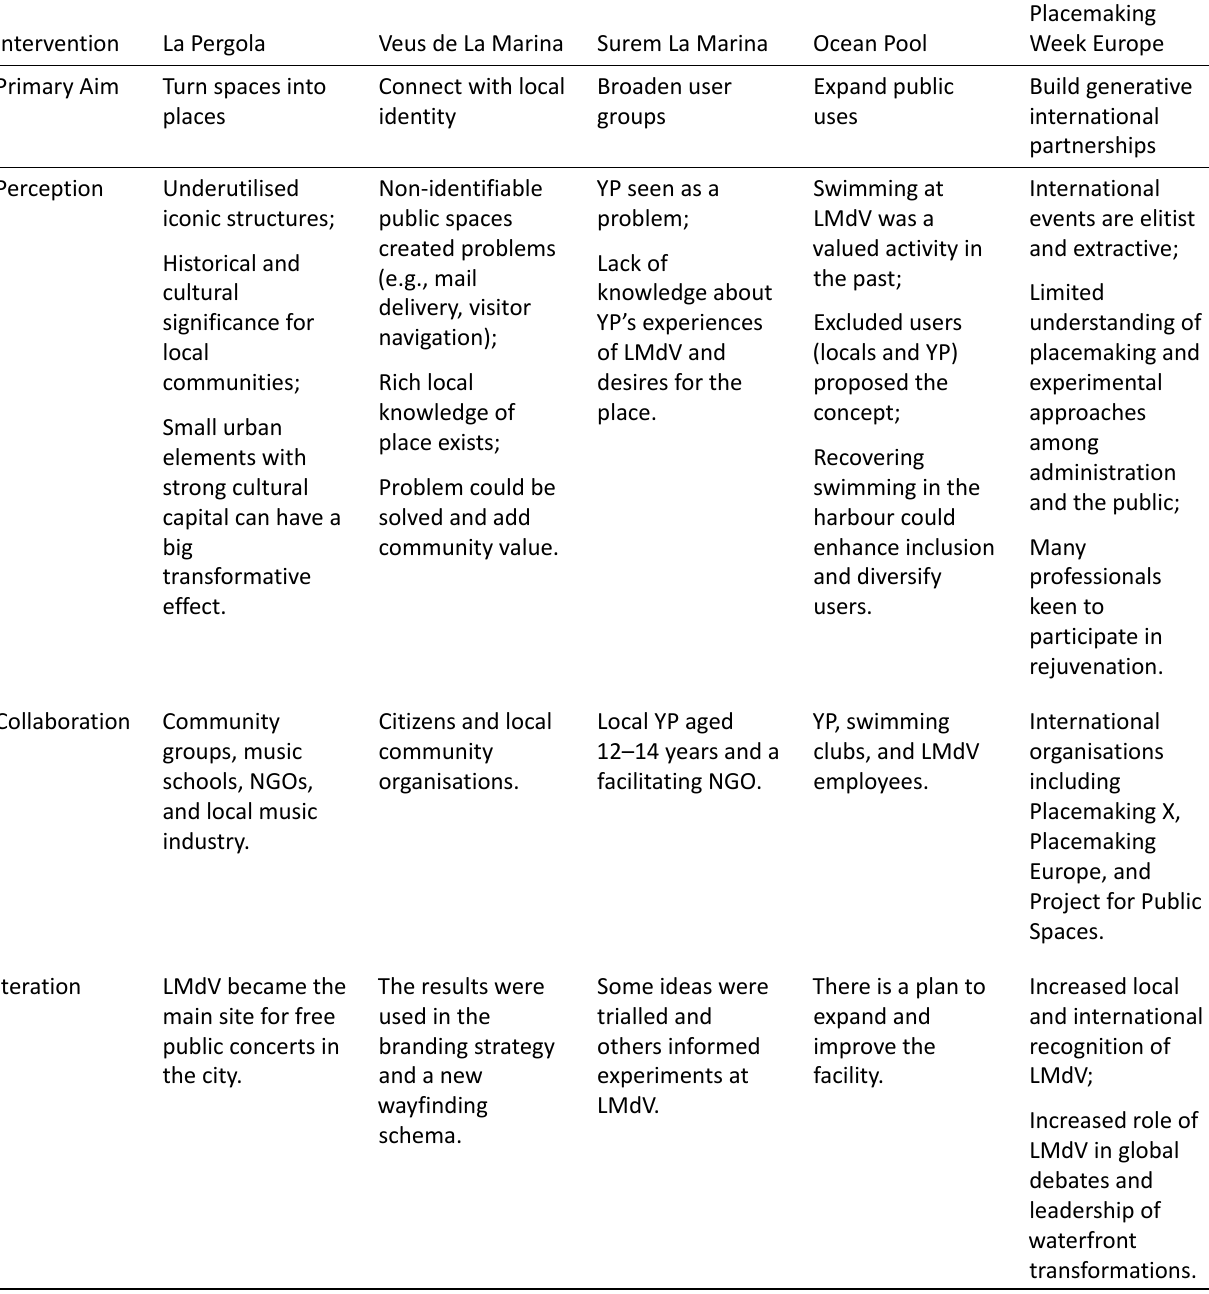
Table 2. Outcomes of selected examples of experiments at LMdV